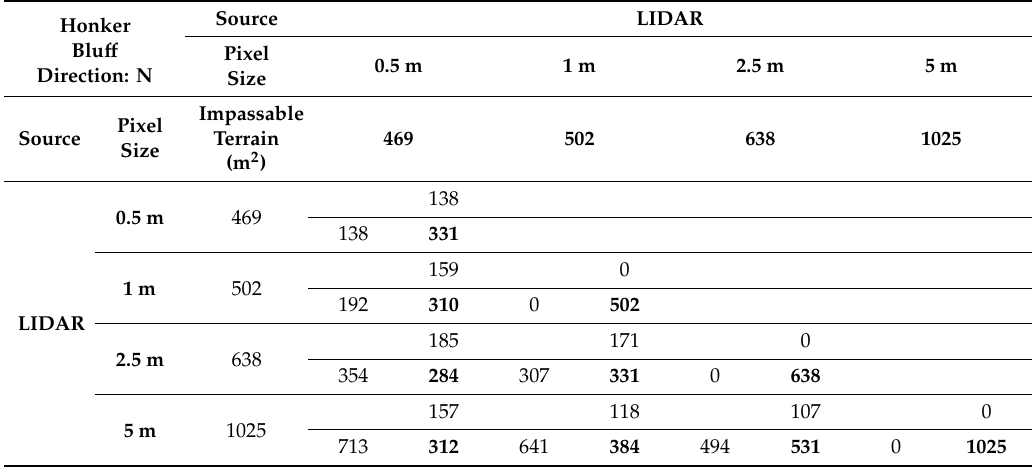
Table 7. Intersection between impassable areas of the Honker moving northward in blu ff terrain (LIDAR data).